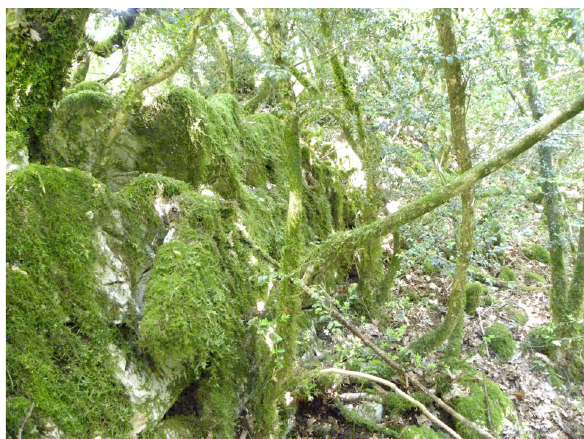
Figure 11. Standing architecture on the scale of 40cm wide and 60cm tall, like the wall pictured here, is not successfully identified using the proposed approach.